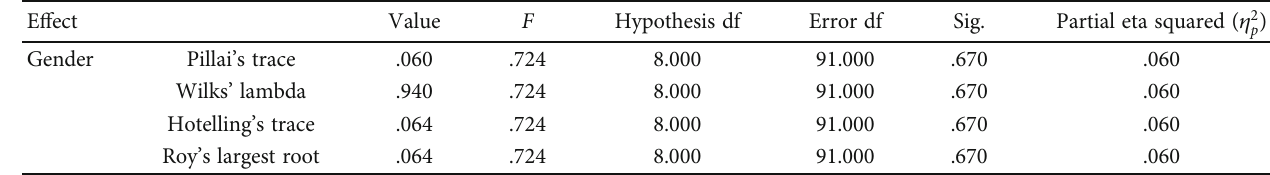
Table 6: MANOVA results of di ff erences in the use of multiple intelligences based on gender. E ff